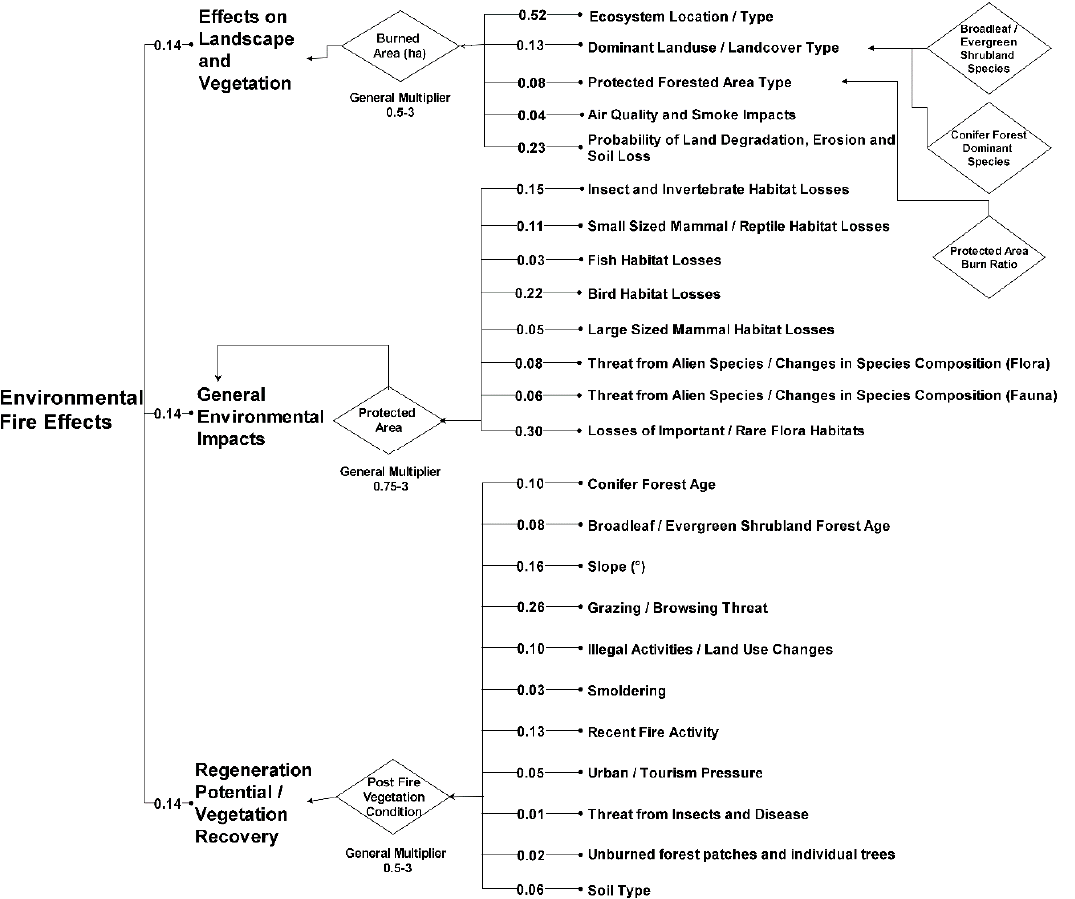
Figure 1. Flowchart of how the 24 criteria attributed to the evaluation of environmental fire effects group were assigned to the three fire effects categories. Numbers denote the weight of each criterion and category, as derived by the expert evaluation of relative criterion importance analysis with the analytical hierarchical process (see Sections 2.3 and 2.4). General multipliers are described in Section 2.2.3.